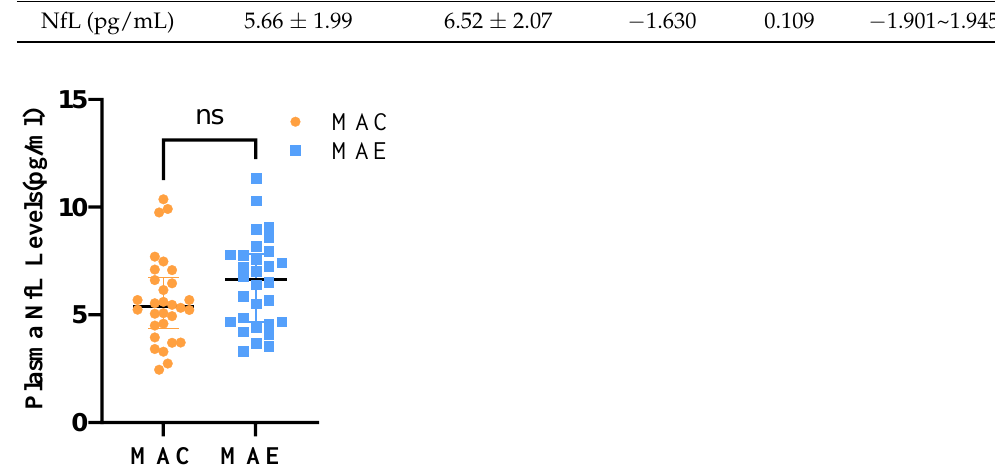
Figure 4. Plasma NfL levels in MAE group and MAC group. ns: There was no significant difference in Plasma NfL in the MAE group compared with the MAC group.